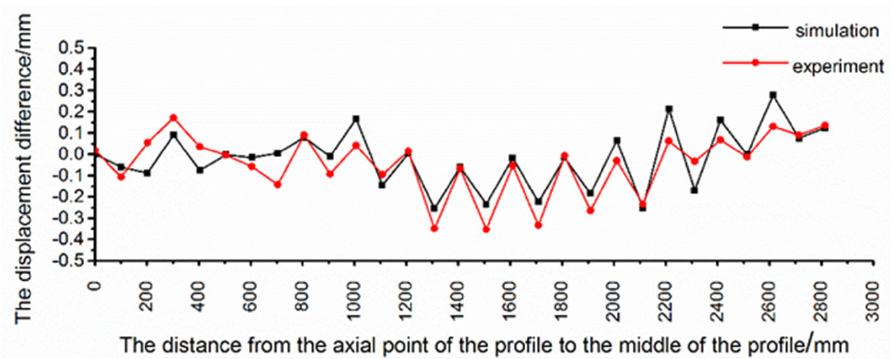
Figure 17. The displacement difference between experiment and simulation.